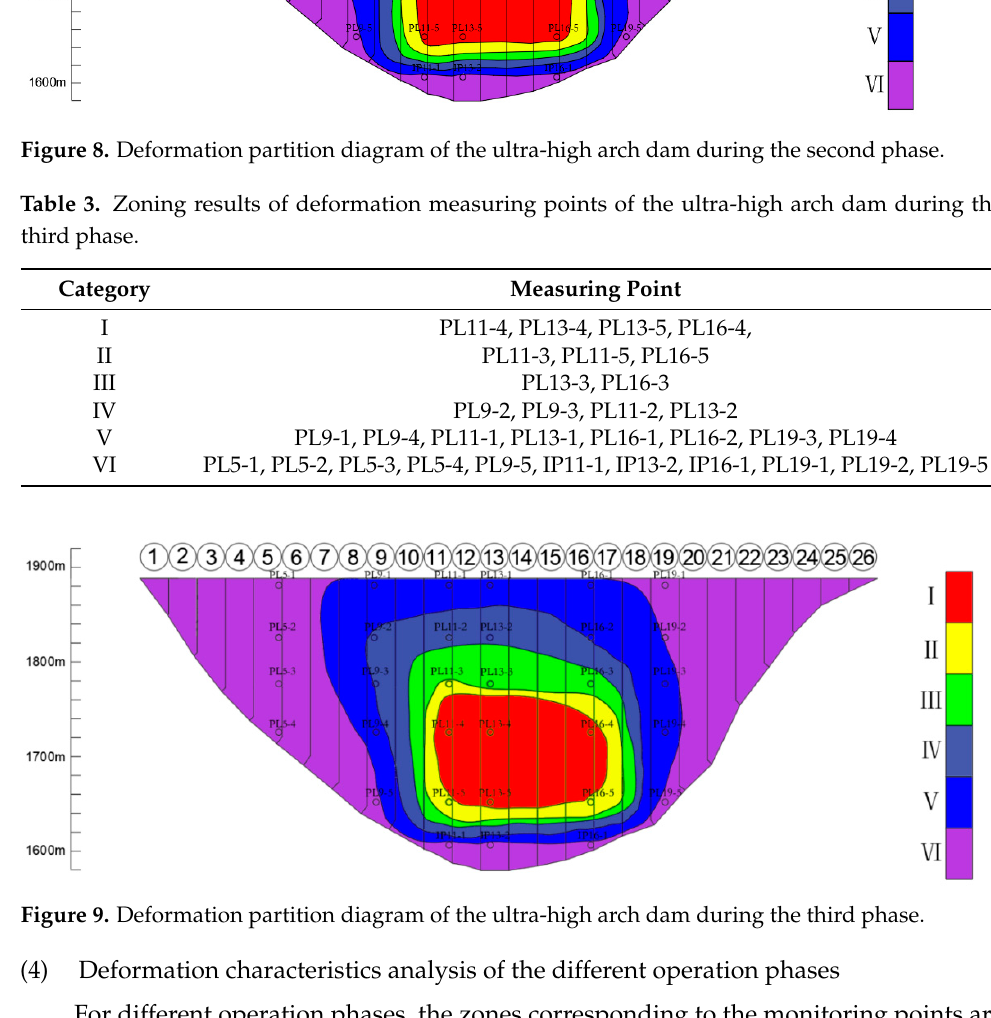
Figure 9. Deformation partition diagram of the ultra-high arch dam during the third phase.